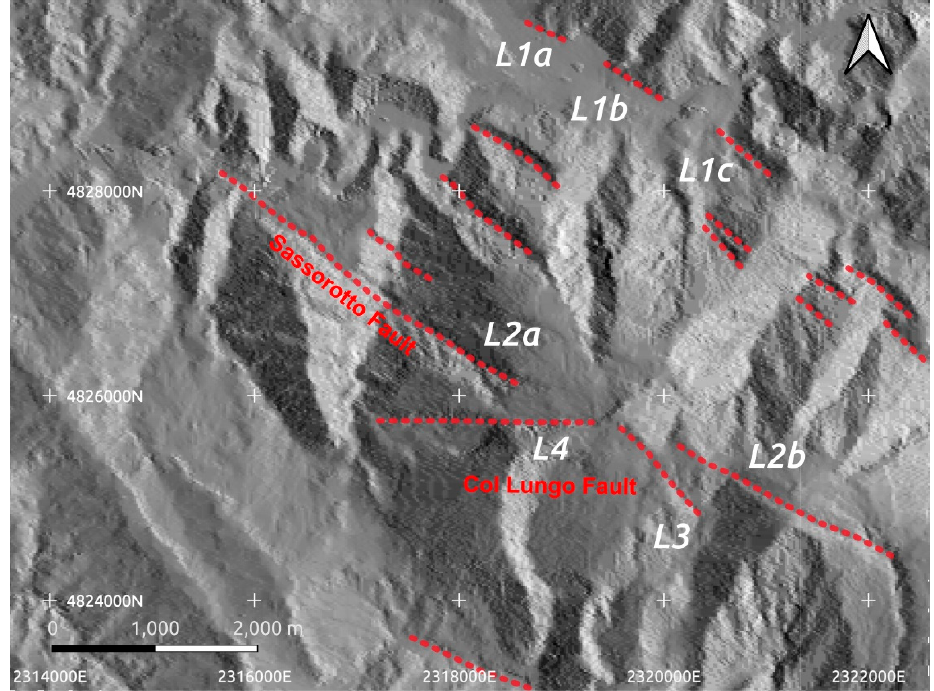
Figure 8. Lineaments interpreted from the directional slope analysis performed with the DirectionalSlope plug-in. The majority of the lineaments had a NW–SE trend, consistent with the orientation of both the northern Apennines thrusts and the successive normal faults. The most developed lineaments were labeled L1 (probably a single fault made up of three segments), L2a, and L2b (almost aligned but without evident connections and probably related to the Sassorotto fault). Lineaments L3 and L4 had more spatial variability and were connected to the Col Lungo fault (see Figure 2 for location).